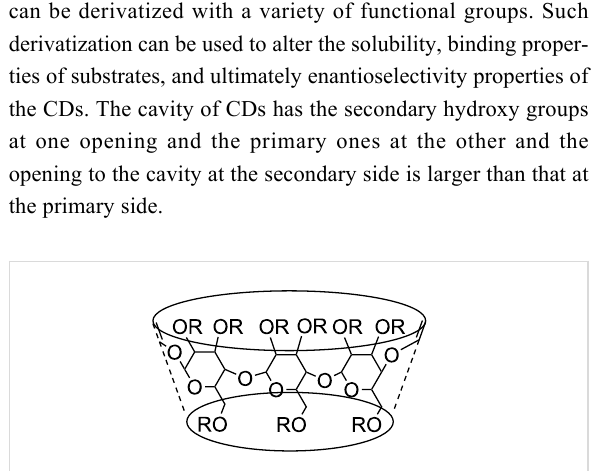
Native, underivatized CDs are effective chiral NMR solvating agents in water [8,9]. Water-soluble substrates with hydro- phobic moieties such as aryl rings typically form inclusion com- plexes by insertion of the aryl ring into the CD cavity.